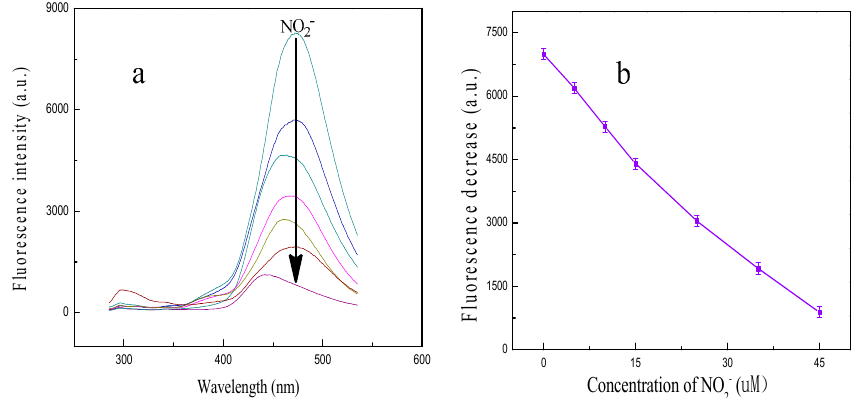
Figure 7. ( a ) Fluorescence titrations of ESIPT-F (10 µ M) in the DMF-HEPES solution ( v / v = 4/1, pH 6.5) solution with different concentrations of NO 2 − (0, 5, 10, 15, 20, 25, and 45 µ M) addition; ( b ) Fluorescence quenching efficiency ( λ ex = 365 nm; λ em = 497 nm) of the probe ESIPT-F at different NO 2 − concentrations.